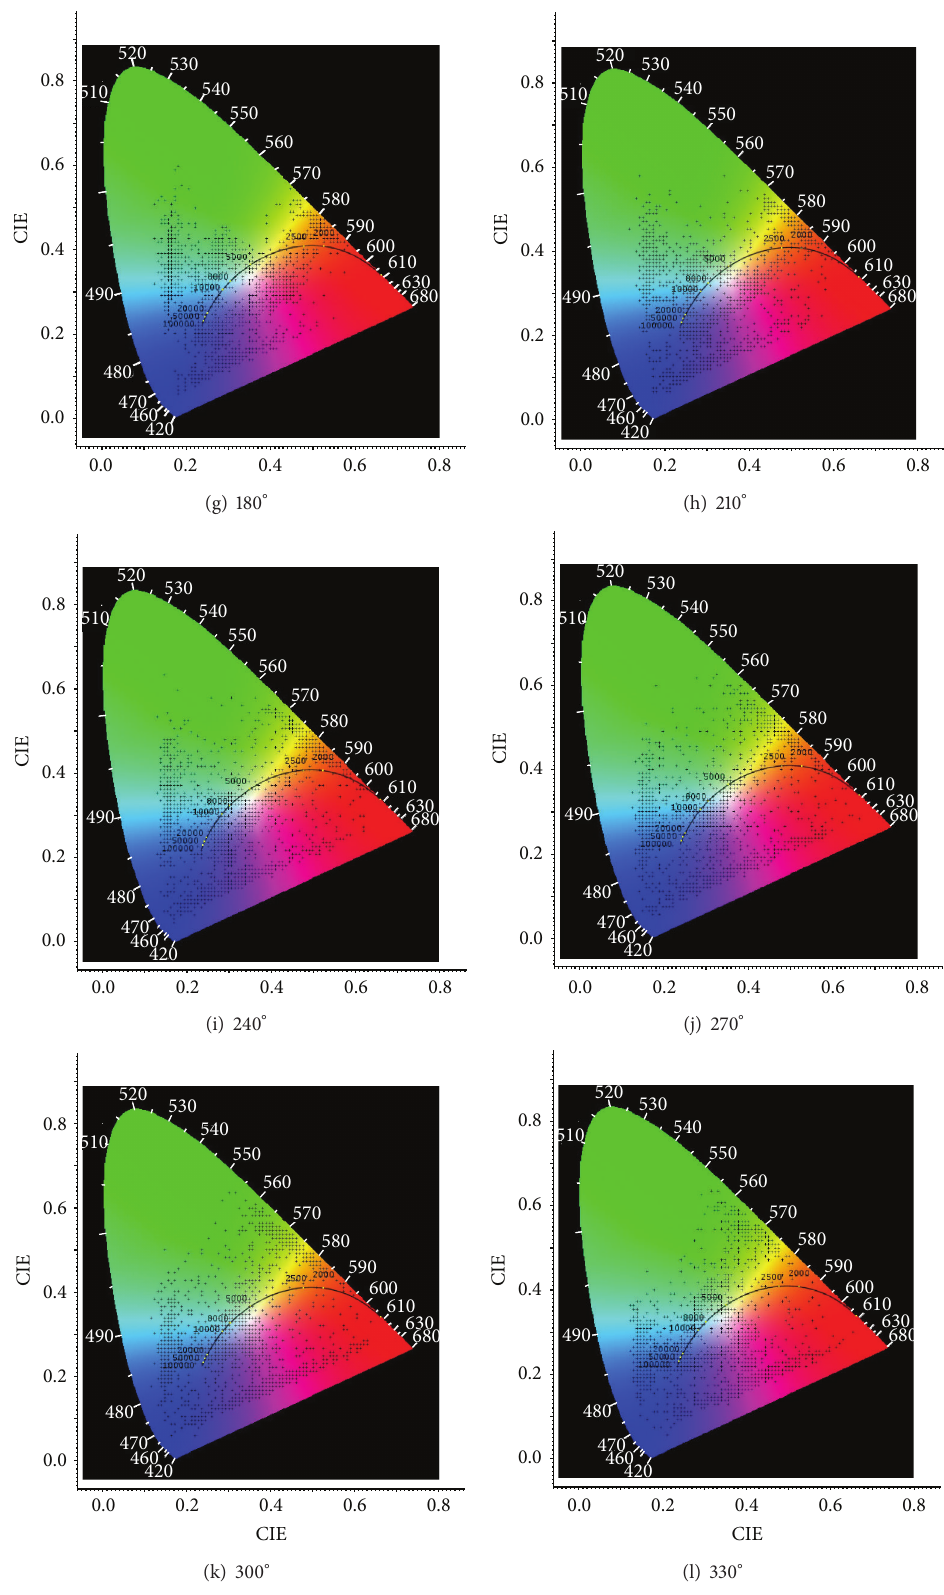
Figure 18: The chromaticity color coordinates for the color mixing